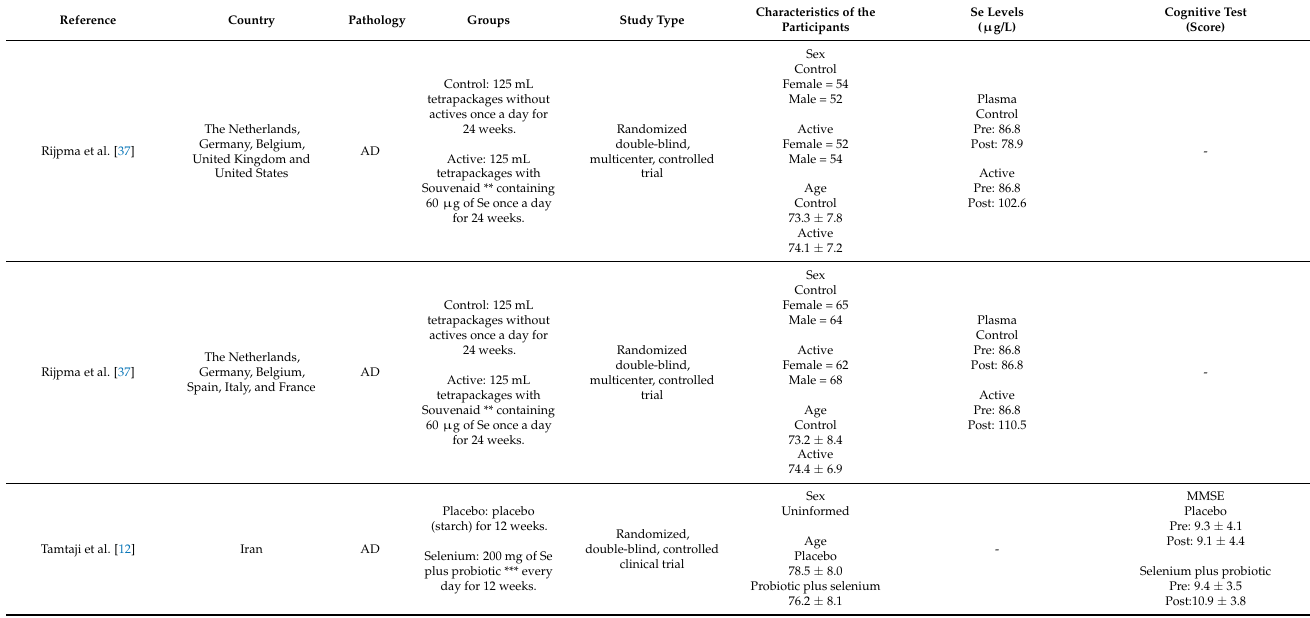
Randomized, double-blind,controlled clinicaltrial